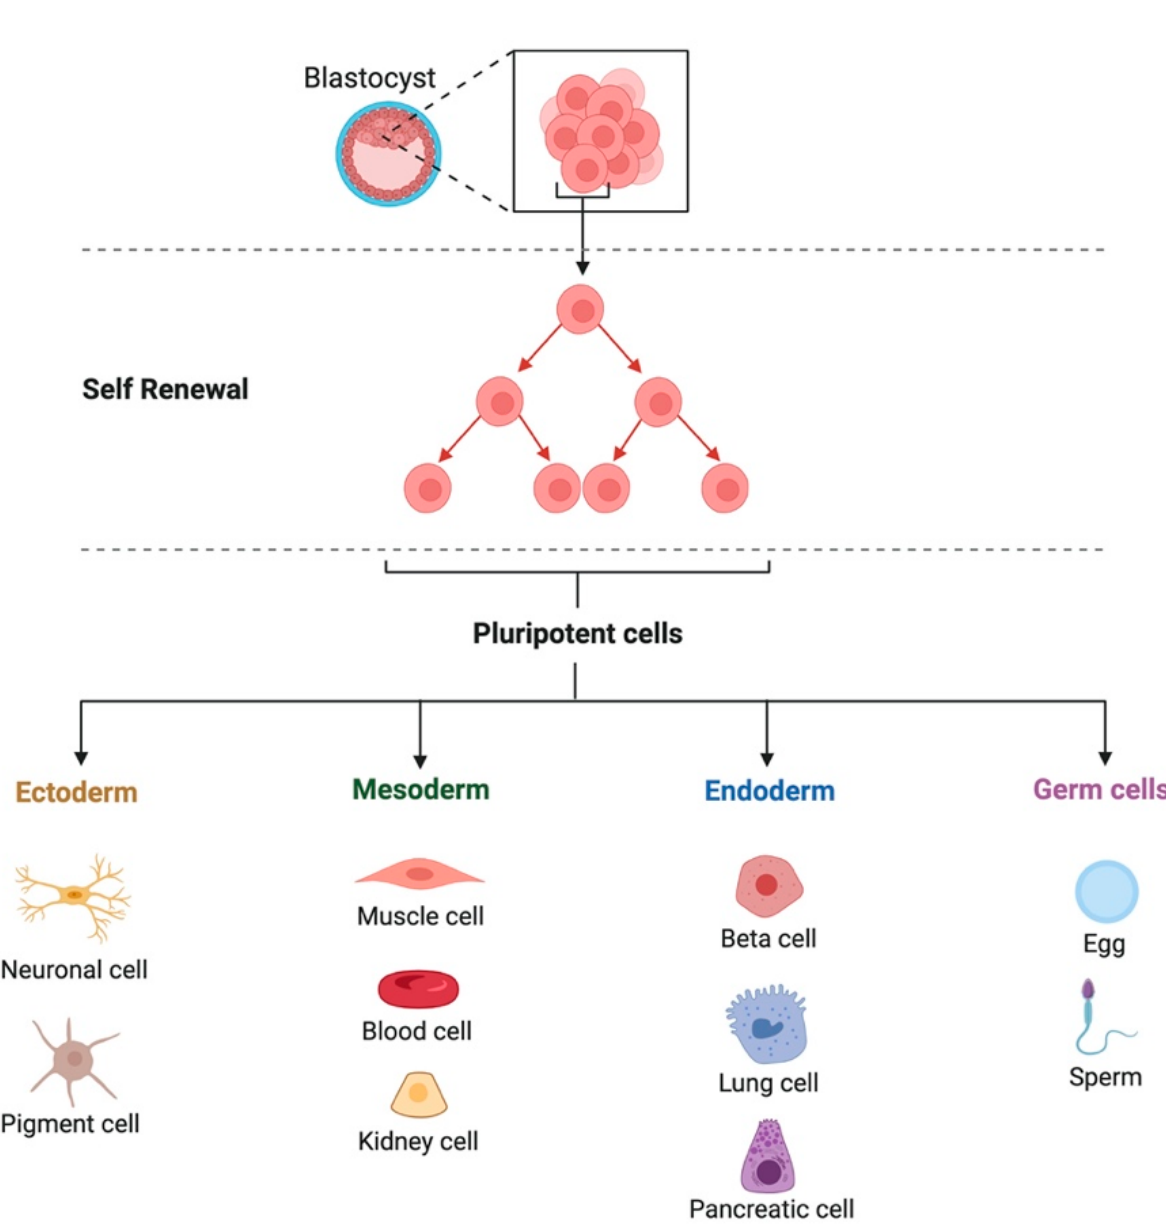
Figure 2. Schematic illustration of the source and multilineage differentiation of embryonic stem cells.